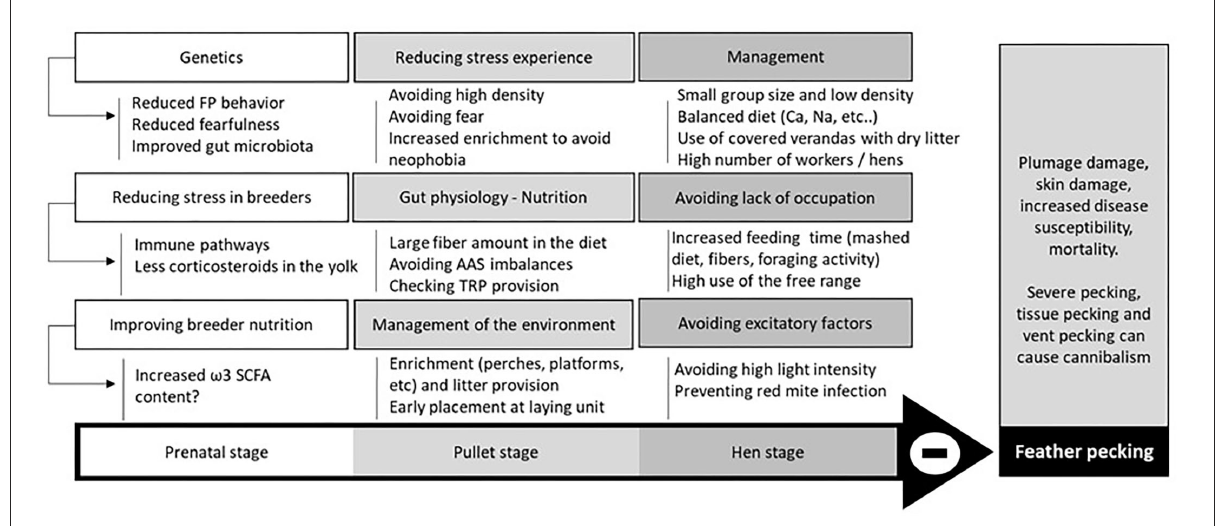
FIGURE3 Practices to prevent feather pecking [Overview from (97–103)]. AAS, Sulfur amino-acids; FP, Feather pecking, SCFA, short chain fatty acids, the increase in omega-3 SCFA in breeders’ diet decreases FP in the offspring in ducks (98), but this demonstration is lacking in hens.